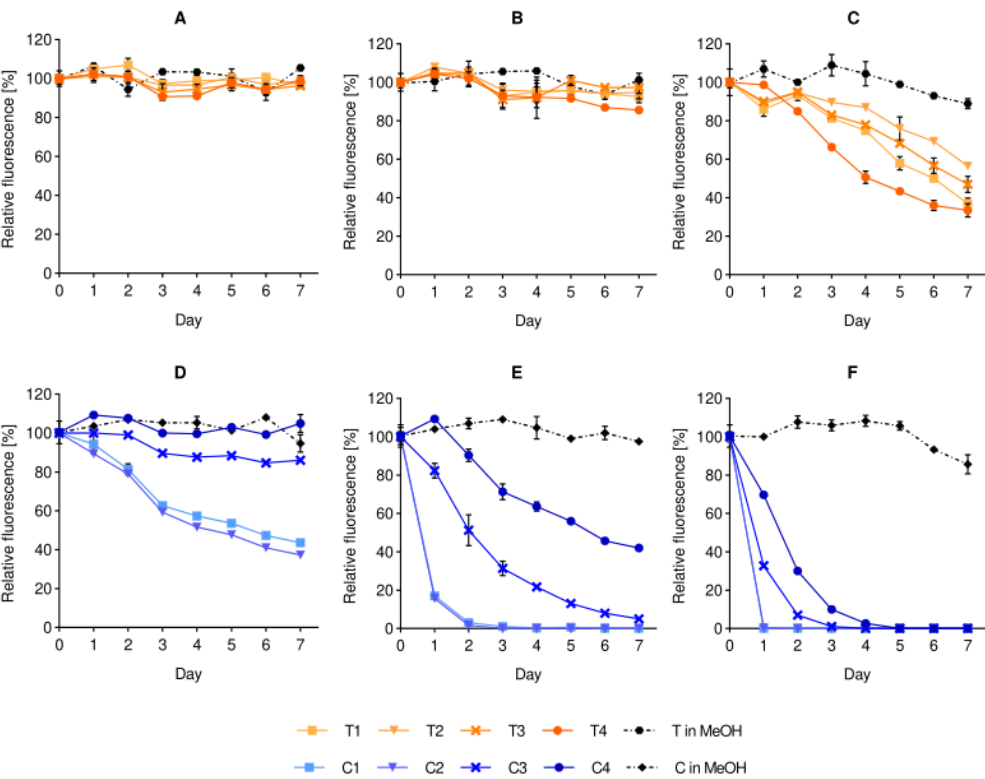
Figure 3. E ff ect of storage temperature on the fluorescence stability of liposomal dyes. The stability of T-containing formulations (panels A – C ) and C-containing formulations (panels D – F ) are compared to their respective dye solutions in methanol after daily sampling at the temperatures of 4 ◦ C ( A , D ), 25 ◦ C ( B , E ) and 37 ◦ C ( C , F ). All formulations were pre-diluted in isotonic bu ff er to fit in the detectable range of the instrument. The fluorescence is expressed as mean (%) ± SD ( n = 3), where 100% is the initial fluorescence value of each formulation (Day 0). Abbreviations: T refers to the lipid dye; C to the surface lipid dye; MeOH is short for methanol; SD is standard deviation.